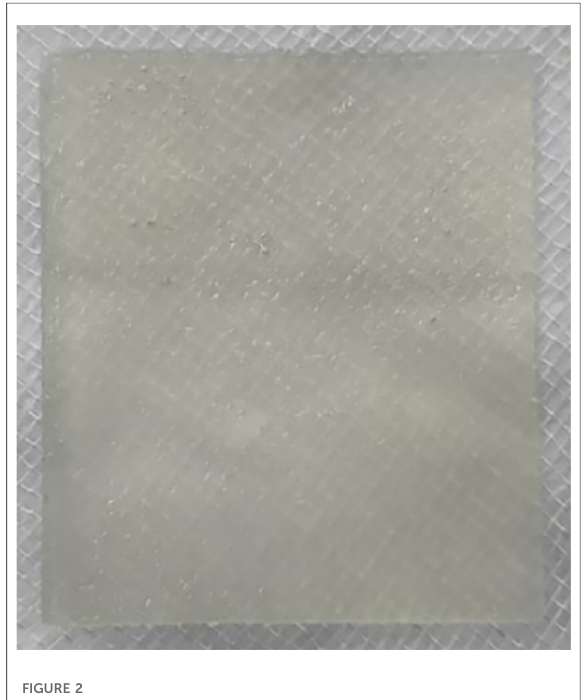
FIGURE 2 Appearance of double-layer arti fi cial